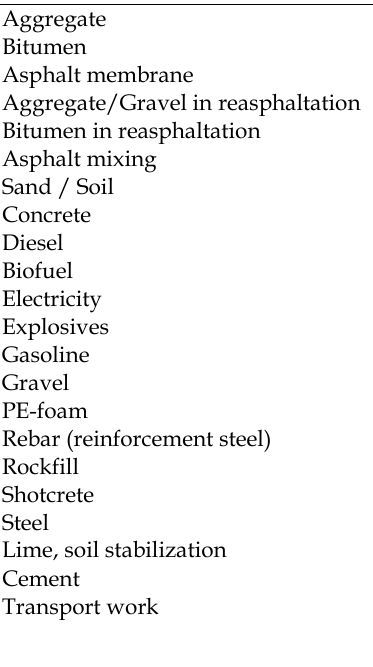
Table B. Greenhouse gas emissions of materials and energy used in the LICCER model Specific greenhouse gas emissions of